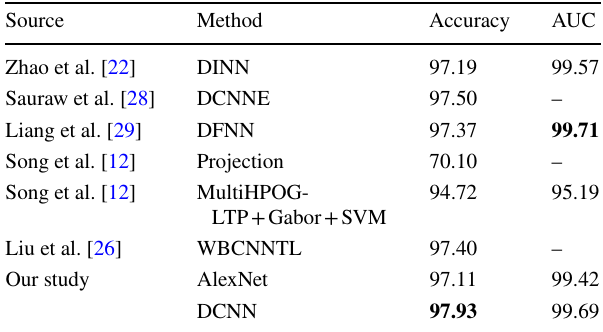
Table 9 Comparison of DCNN and AlexNet architectures and previ- ous studies on CEW dataset